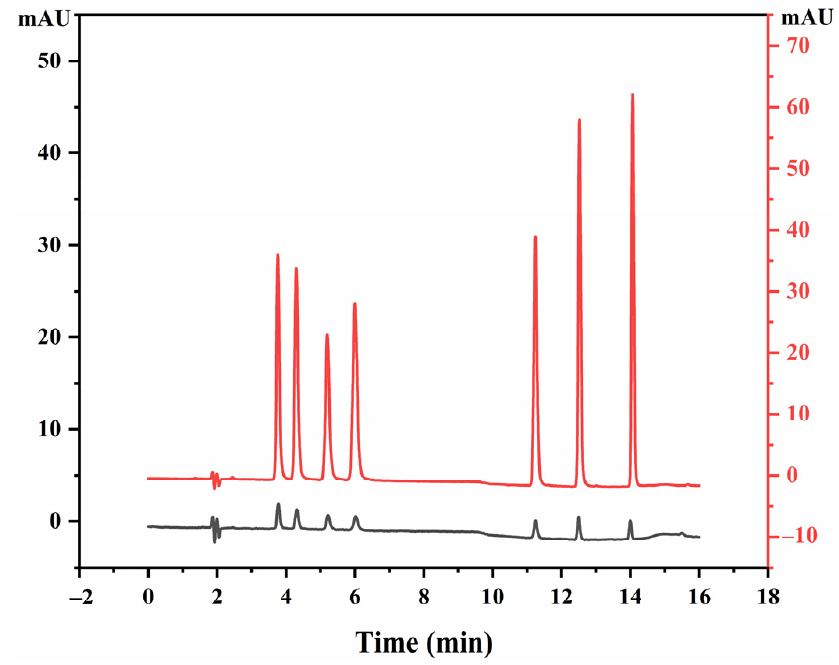
Figure 3. Chromatograms of the SAs standard solution individual at 500 µ g/L (red) with and (black) without DLLME.